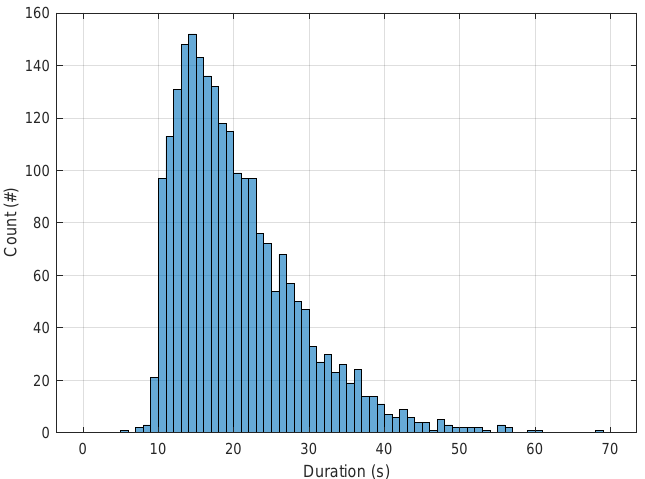
Figure 4. Histogram of apnoea durations, evaluated on the training set.